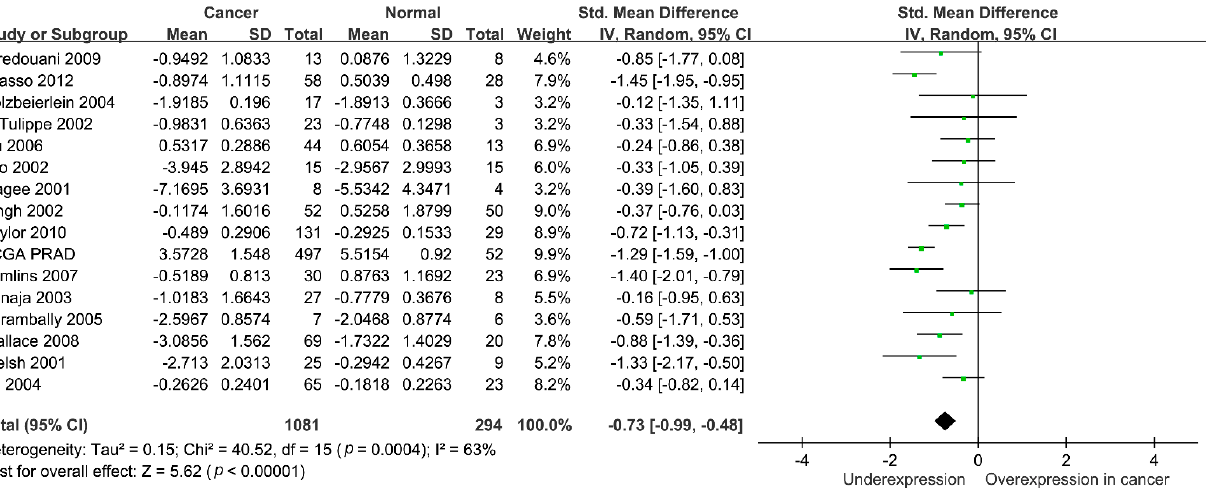
Figure 4. Clinical significance of NRG1 in prostate cancer. ( A ) Down-regulation of NRG1 expression in The Cancer Genome Atlas Prostate Adenocarcinoma samples. A negative correlation between the expression of NRG1 and ( B ) the Gleason score and ( C ) the tumour stage was found. ( D ) Patients with low NRG1 expression exhibited reduced PFS compared to patients with high NRG1 expression. Rho ( (cid:36) )—Spearman’s rank correlation coefficient. Values in brackets represent the number of patients.